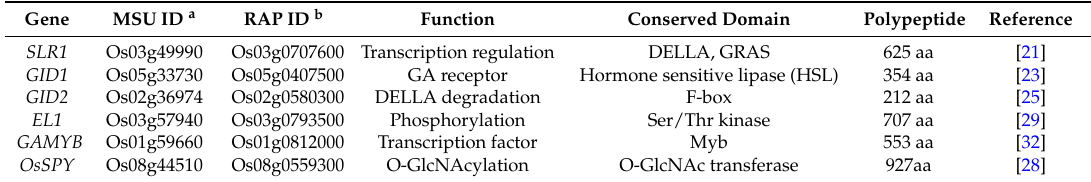
Table 1. Genes involved in gibberellic acid (GA) signaling in